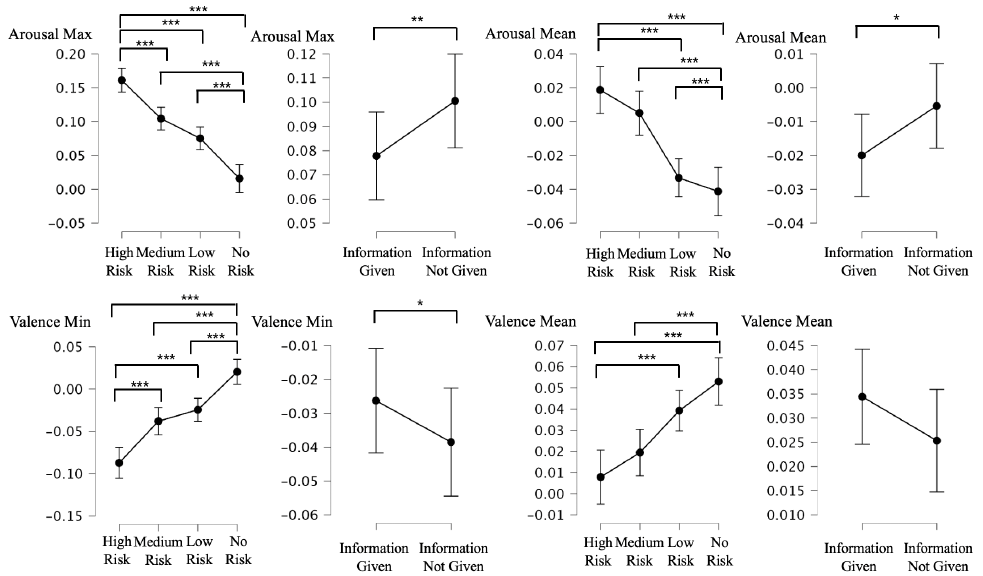
Figure 7. A graph that compares the maximum and mean value of Arousal data and the minimum and mean value of Valence data according to risk level and whether or not information was provisioned through HUD. The use of asterisks in the figure indicates statistical significance. A single asterisk (*) denotes a p -value less than 0.05, while two (**) and three (***) asterisks denote p -values less than 0.01 and 0.001,